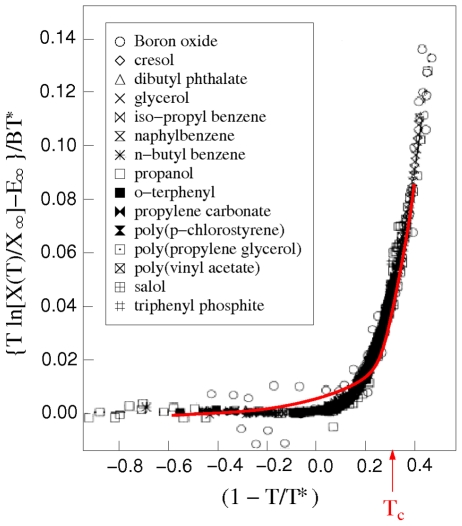
Comparison of an effective temperature-dependent activation barrier obtained from experimental data (symbols) [4] with similarly reduced results of the Network model (solid curve).The value of T* is 0.63 for the Network model.